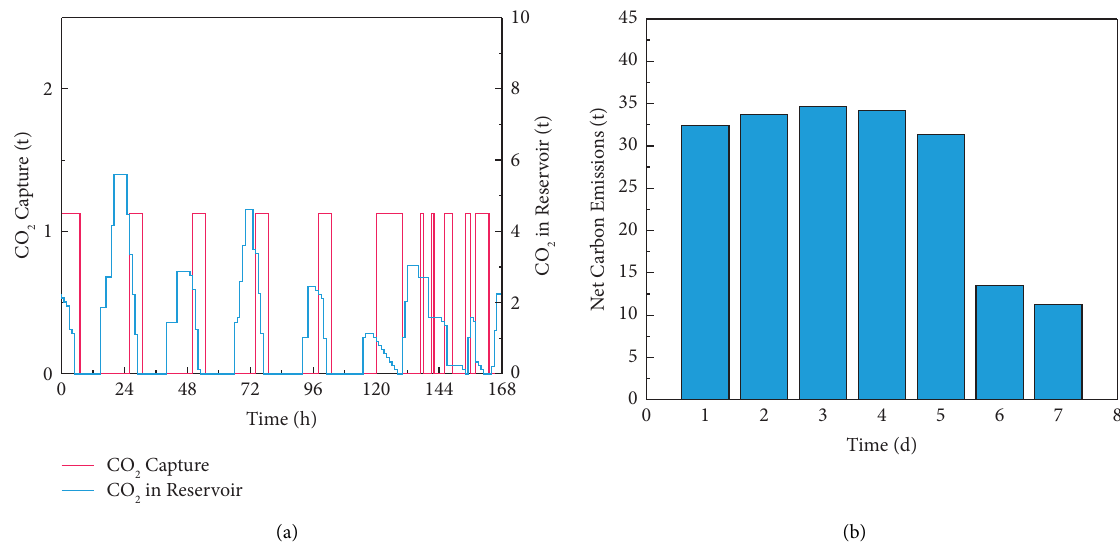
Figure 7: Operation condition of the carbon capture gas turbine unit when λ C � 50 E . (a) Carbon capture and CO carbon emissions of the gas turbine.